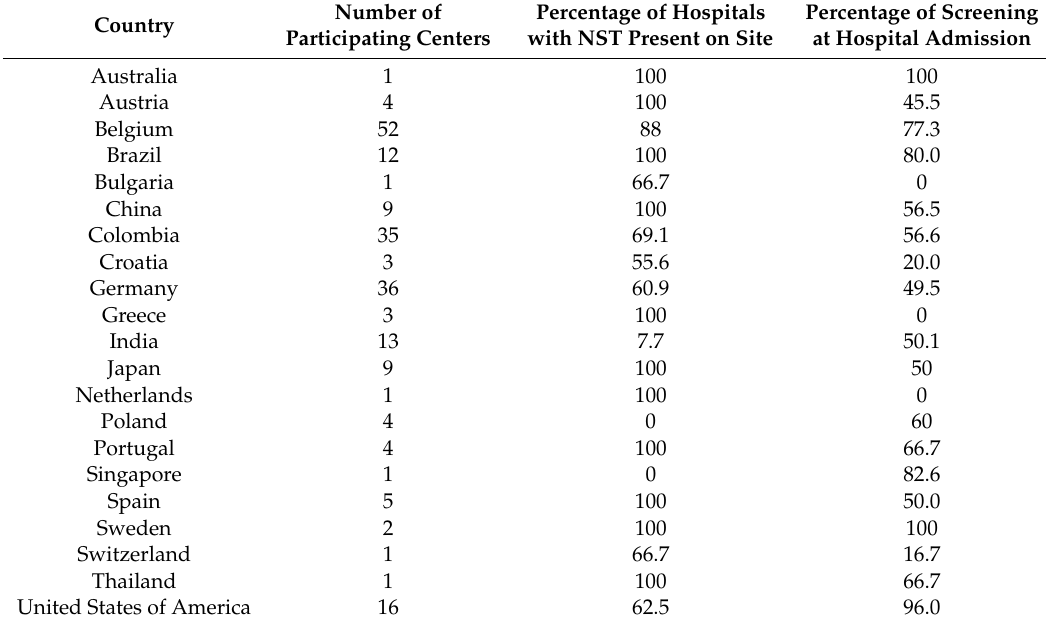
Table 1. National reports from the nutritionDay 2018, available from https: // www.nutritionday.org / en / about-nday / national-reports /